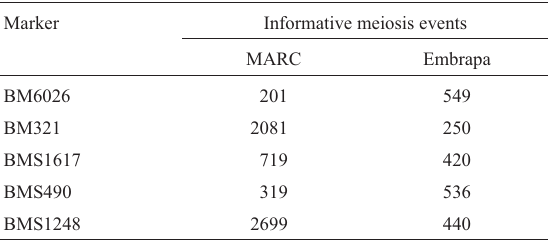
Table 4 - Number of informative meiosis events for each marker on the data used to build the reference map (http://www.marc.usda.gov) and to build the Embrapa map.